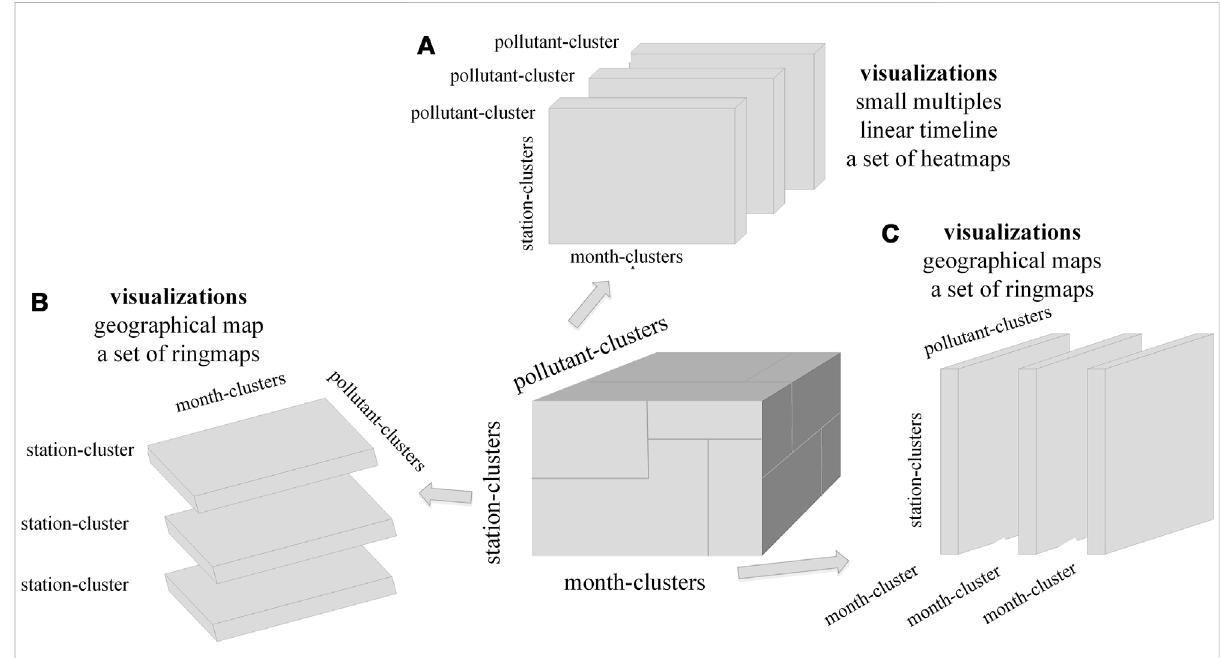
FIGURE 4 Exploration of tri-clustering results from different perspectives ( (A) : pollutants, (B) : stations, (C) : months) using the small multiples, linear timeline, heatmap, and ringmap.